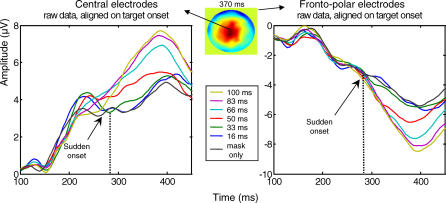
Sudden Onset of a Nonlinear Variation of Evoked Activity with SOAThe figure shows the mean amplitude of nonsubtracted ERPs aligned on target onset, measured on central (left panel) and fronto-polar electrodes (right panel). The voltage map shows the topography at the peak of the P3 waveform (latency 370 ms), in the SOA = 100 ms condition. In both graphs, ERPs show a nonlinear increase in amplitude with SOA, with a sudden onset around 270–300 ms.